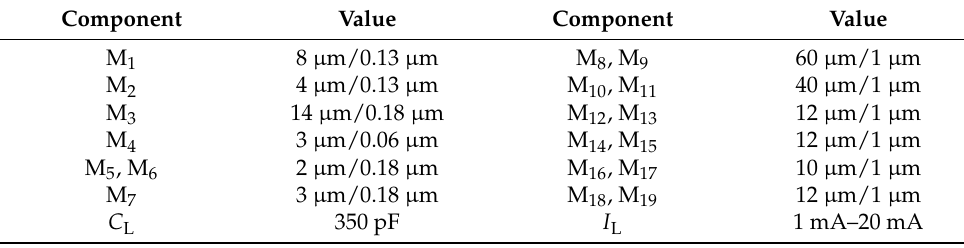
Figure 1. ( a ) Schematic diagram, ( b ) simplified schematic diagram, and ( c ) block of the proposed FVF LDO. Table 1. List of the component values in the proposed FVF